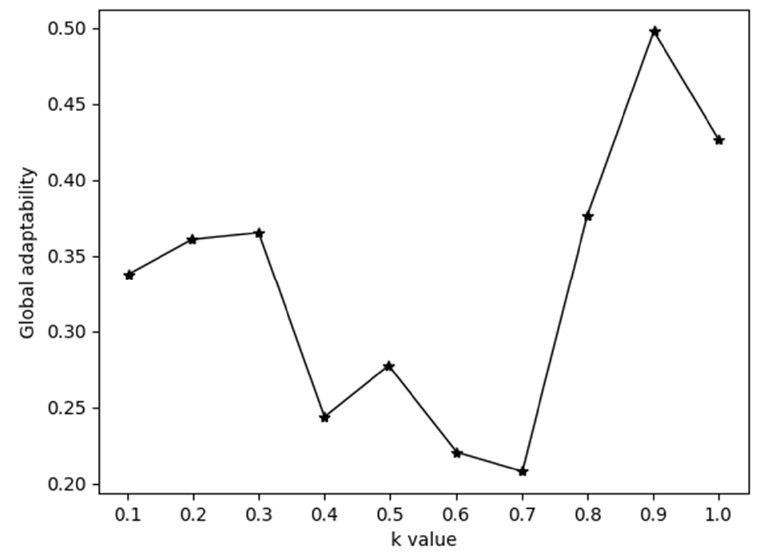
Figure 14. Effect of maximum particle velocity on model performance.